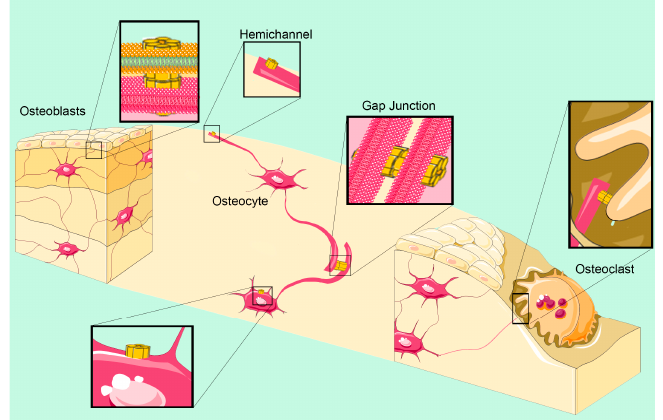
Figure 2. Schematic representation of Cx43 gap junctions and hemichannels in bone cells. Through gap junctions located in their long dendritic processes, osteocytes embedded in the deep lacunae are able to make connections with each other and with other bone cells such as osteoblasts and osteoclasts, in spite of the surrounding mineralized matrix. The resulting “functional syncytium” allows diffuse intercellular propagation of metabolites, second messengers and Ca ++ waves. Through hemichannels, osteocytes may sense a variety of extracellular cues (mechanic stimuli, bio- chemical signals (hormones, growth factors, cytokines)), or release signaling molecules (PGE 2 , ATP, NAD + ) into the external environment. Among bone cells, it is generally recognized that osteocytes are the principal cells acting as mechano-sensors [30]. Osteocytes and their processes are surrounded by a fluid- filled environment that extends through the lacuna–canaliculi network. This interstitial fluid is a major stress-related factor that transmits mechanical stimulation to other GJ- interconnected bone cells. Mechanical loading produces a movement of the interstitial fluid that is sensed by the osteocytes through integrins, cilia, calcium channels, and G- protein coupled receptors, which act as mechano-sensors. Together with the opening of Cx43 hemichannels [31], mechanical stimuli are transduced in biochemical signals that are